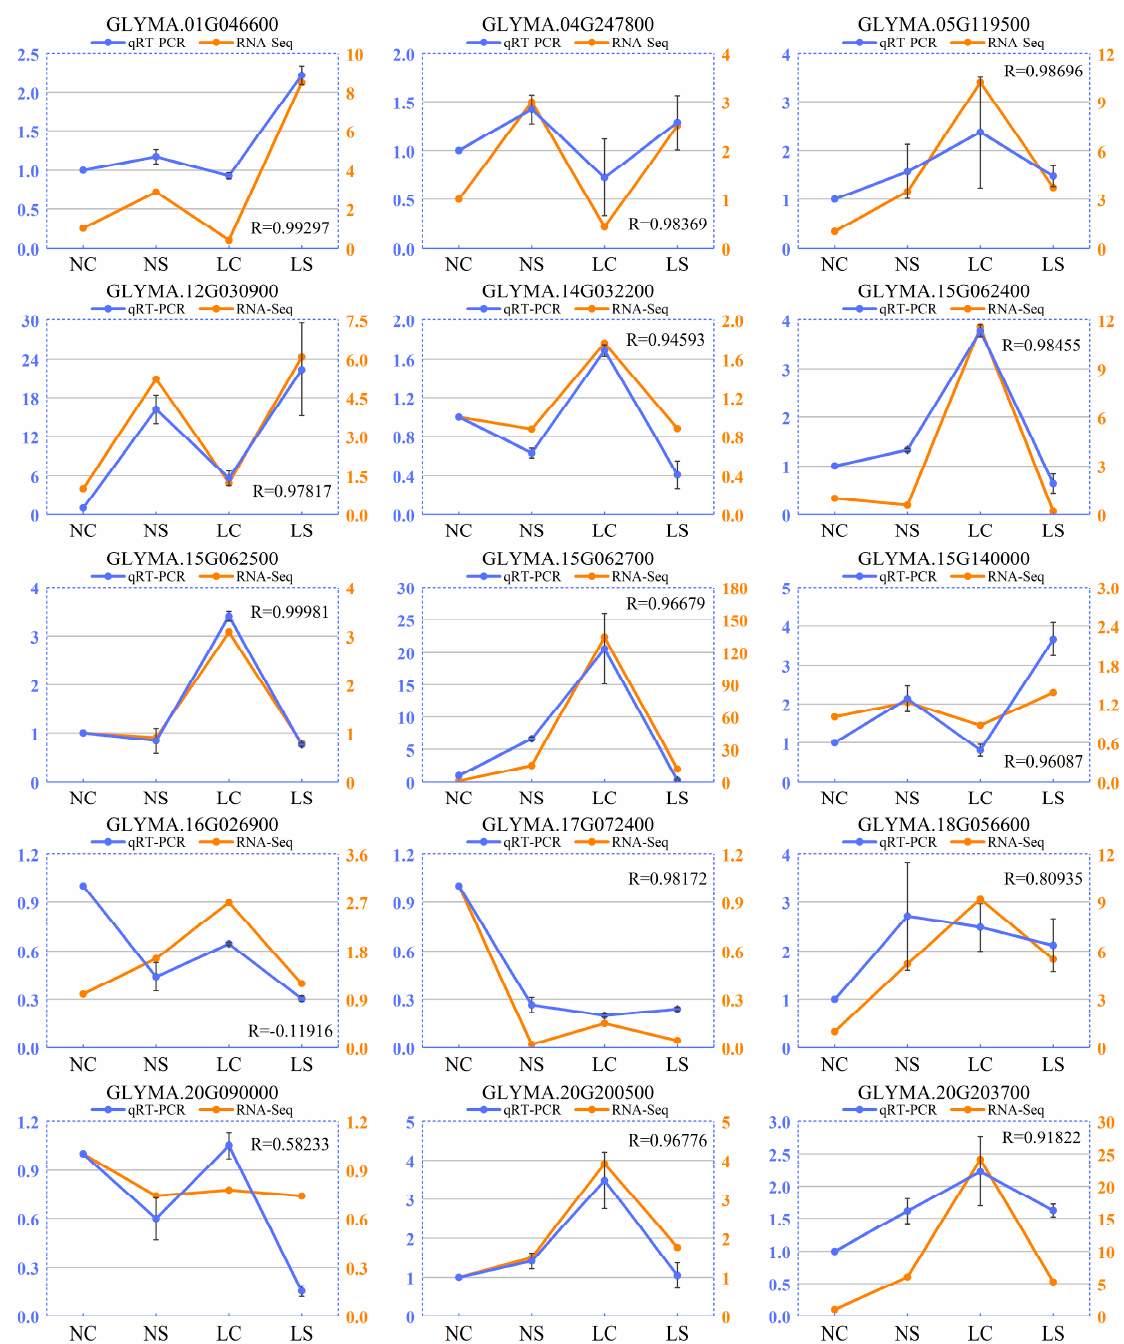
Figure 5. Comparison of the relative expression level change of 15 selected DEGs by qRT-PCR and RNA-seq. Left vertical axis coordinate is relative expression level of qRT-PCR (blue); right vertical axis coordinate is RPKM of RNA-Seq (orange). R-values are the correlation coe ffi cients between qRT-PCR and RNA-seq. NS and NC refer to SMV infection and control, respectively, under normal light, while LS and LC refer to SMV infection and control, respectively, in the